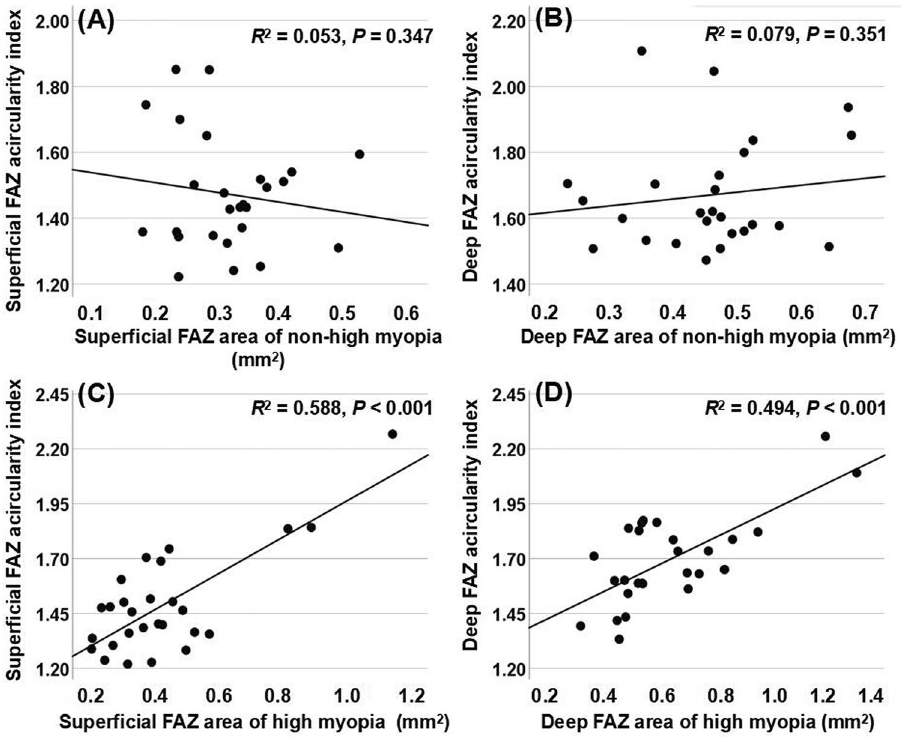
Figure 1. Scatter plots showing the association between the foveal avascular zone (FAZ) areas and acircularity index of FAZ. ( A , B ) The areas of the superficial and deep FAZ were not significantly correlated with the acircularity index in the non-high myopia group. ( C , D ) The areas of the superficial and deep FAZ were strongly associated with the acircularity index in the high myopia